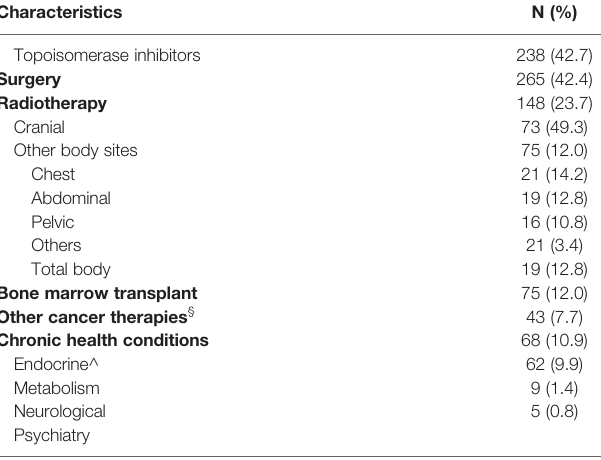
TABLE 1 | Characteristics of study population (n = 625).